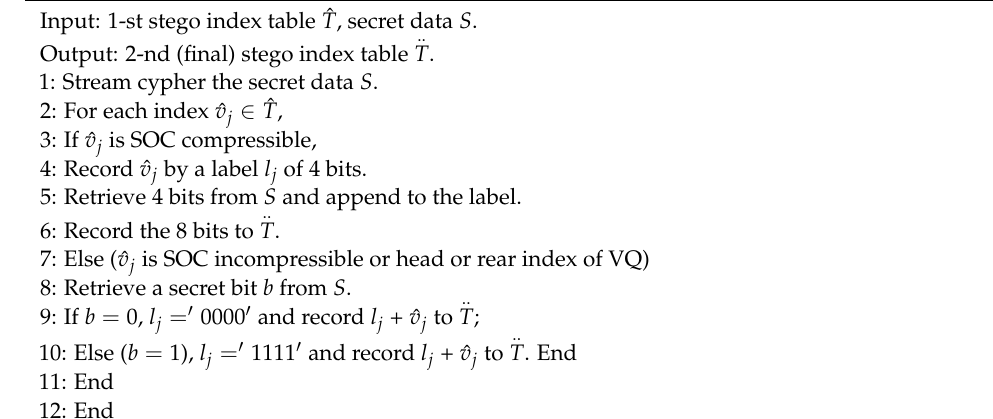
Algorithm 2 . SOC and the second-layer of data embedding for stego VQ index